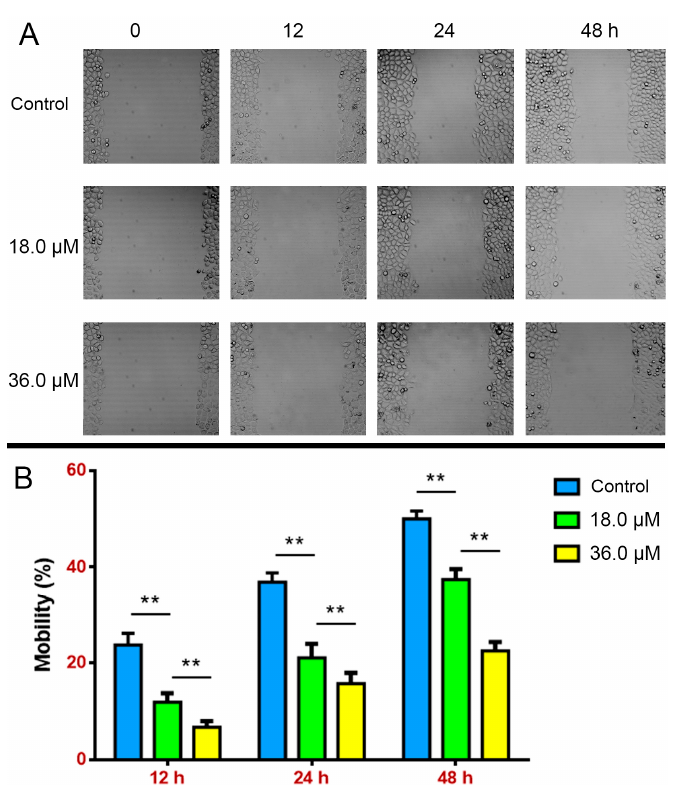
Figure 2. DEFL1 inhibition of A549 cells growth and migration. ( A ) Microscopic observation of A549 cells wound healing results after treatment of different concentrations for the indicated time; ( B ) Statistical analysis results of different concentration groups compared at 12, 24 and 48 h, respectively.** p < 0.01.